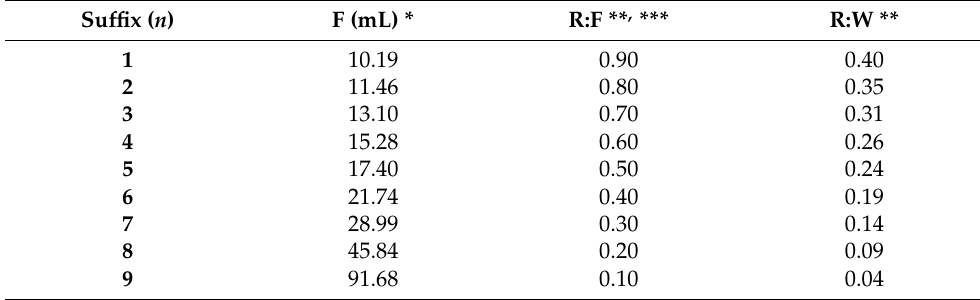
Table 1. Recipes for RFG n and subsequent RFG n -AC sample *. Suffix ( n ) F (mL) * R:F ** ,